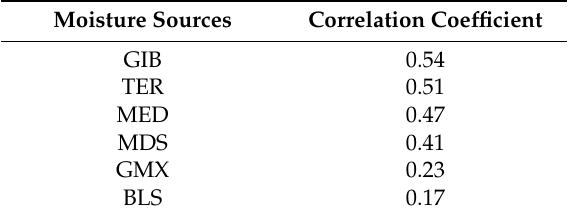
Table 6. Pearson correlation coefficients between the time series of monthly anomalies in the moisture supply from the sources to the Mediterranean region and the SPEI-1 for the period 1980–2015 (432 times). The coefficients are significant at 99.9% for all of the sources, according to Student’s t -test. Moisture Sources Correlation